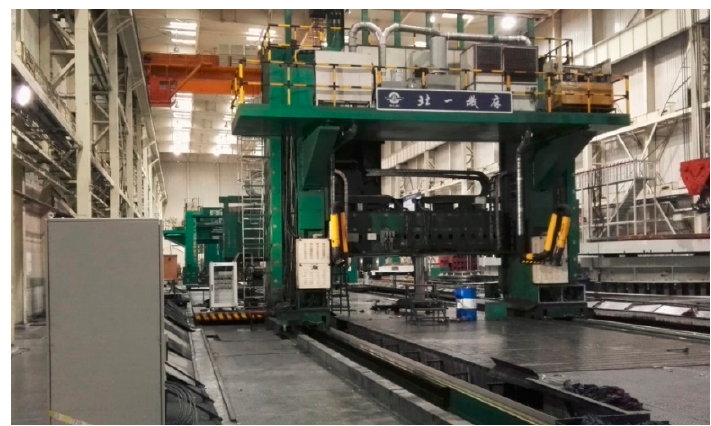
Figure 3. Working environment.